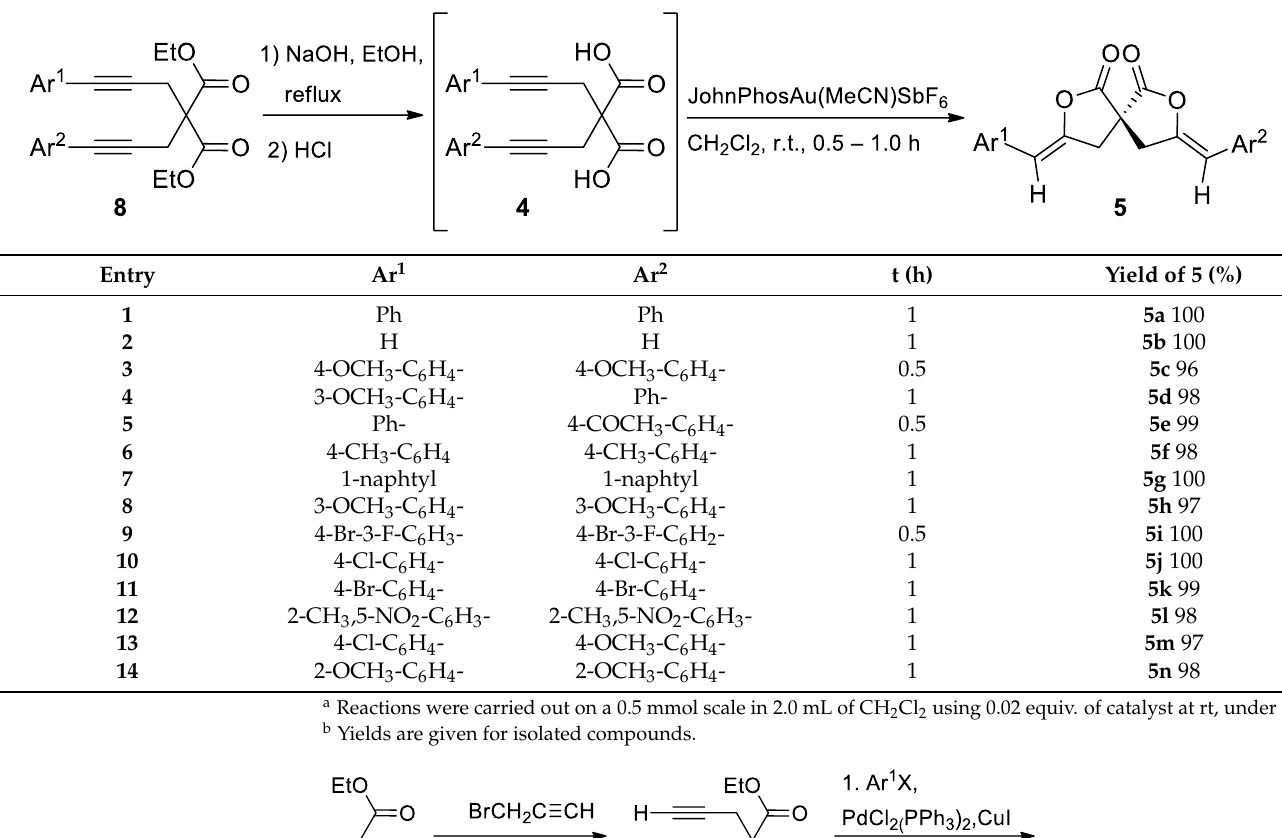
Table 2. Substrate scope for the gold(I)-catalyzed spirodilactonization to γ -arylidenespirobislactones 5 a,b .